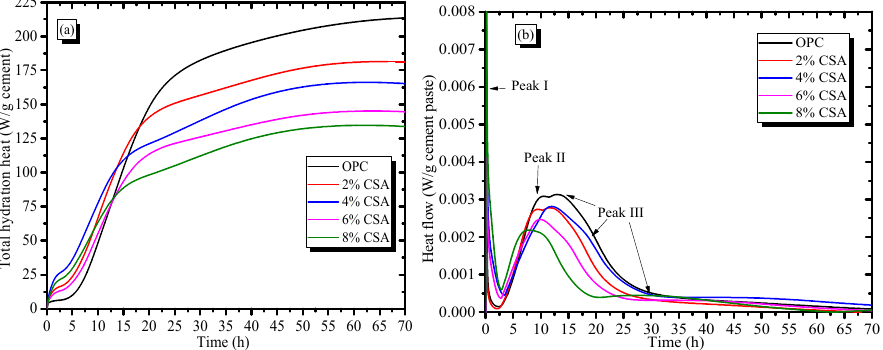
Figure 4. Effect of the CSA cement on the hydration kinetics of OPC, ( a ) The hydration heat; ( b ) The heat flow.